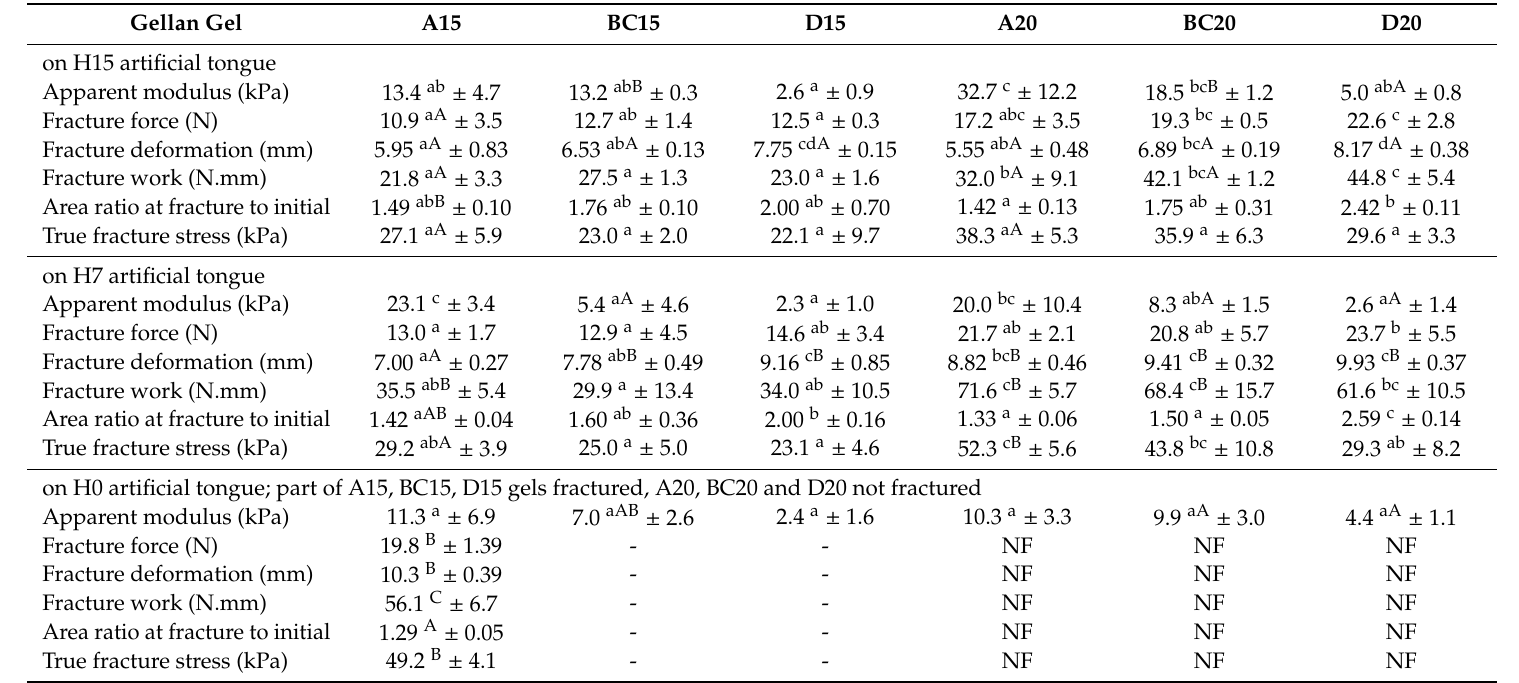
Table 5. Mechanical characteristics of gellan gels measured by the soft